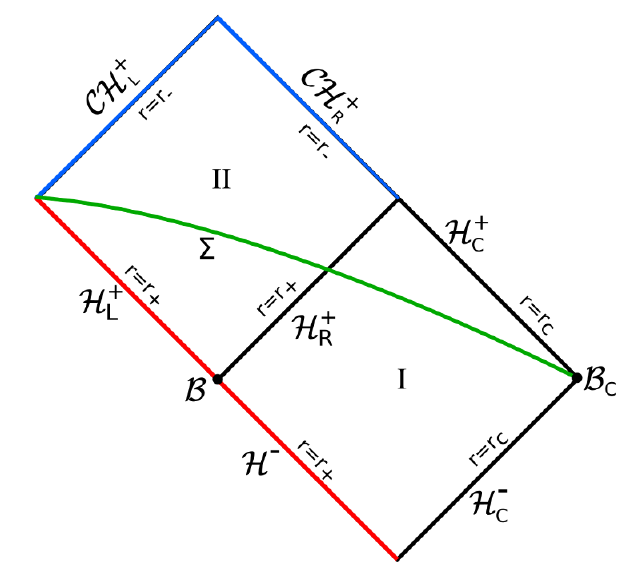
Figure 1 . Penrose diagram for Reissner-Nordstr(cid:127)om de Sitter. Region I is the black hole exterior and region II the interior. The future event horizon is H + and CH + are the future Cauchy horizon. (cid:6) is a Cauchy surface for regions I and L;R